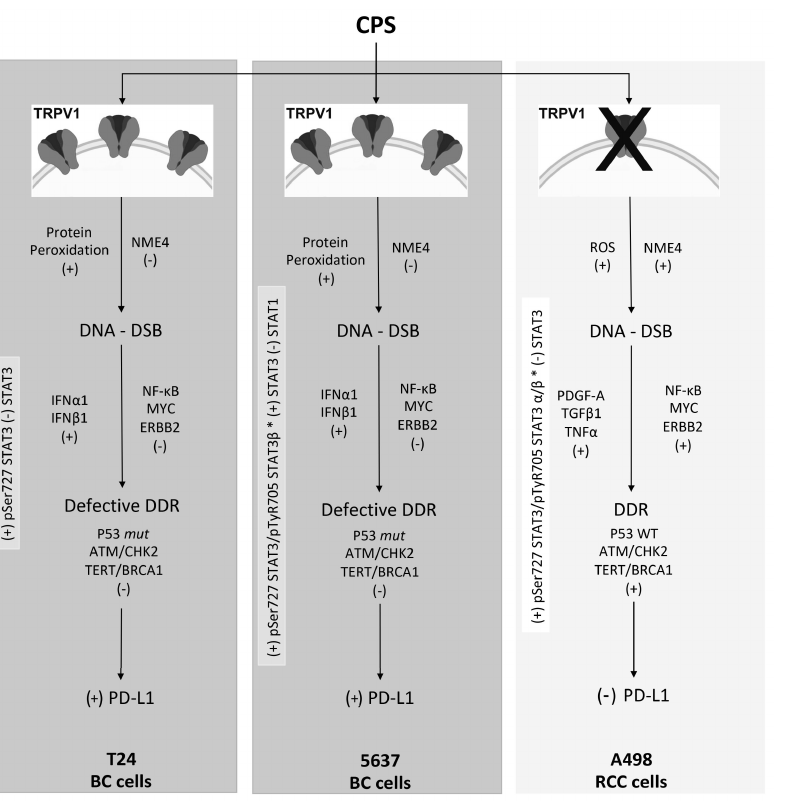
Figure 9. Molecular mechanisms of CPS-induced PD-L1 modulation in BC and RCC lines. ROS, reactive oxygen species; DDR, DNA damage response; DSB, double-strand breaks; mut , mutant; WT, wild-type; +, increased/activated; -,